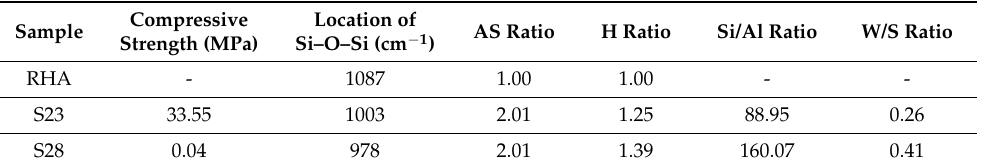
Table 11. Inverted peak area and AS ratio from FTIR spectra of RHA and geopolymer samples at Si–O–Si stretching vibration in a compressive